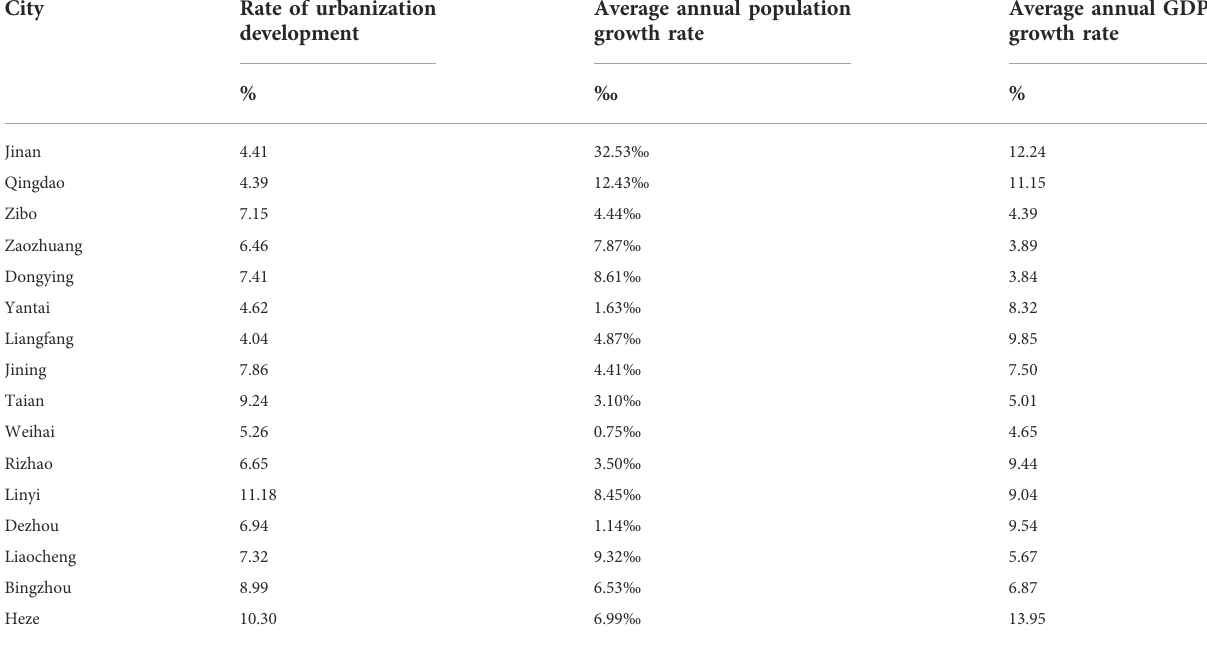
TABLE 3 Data on dynamic indicators by